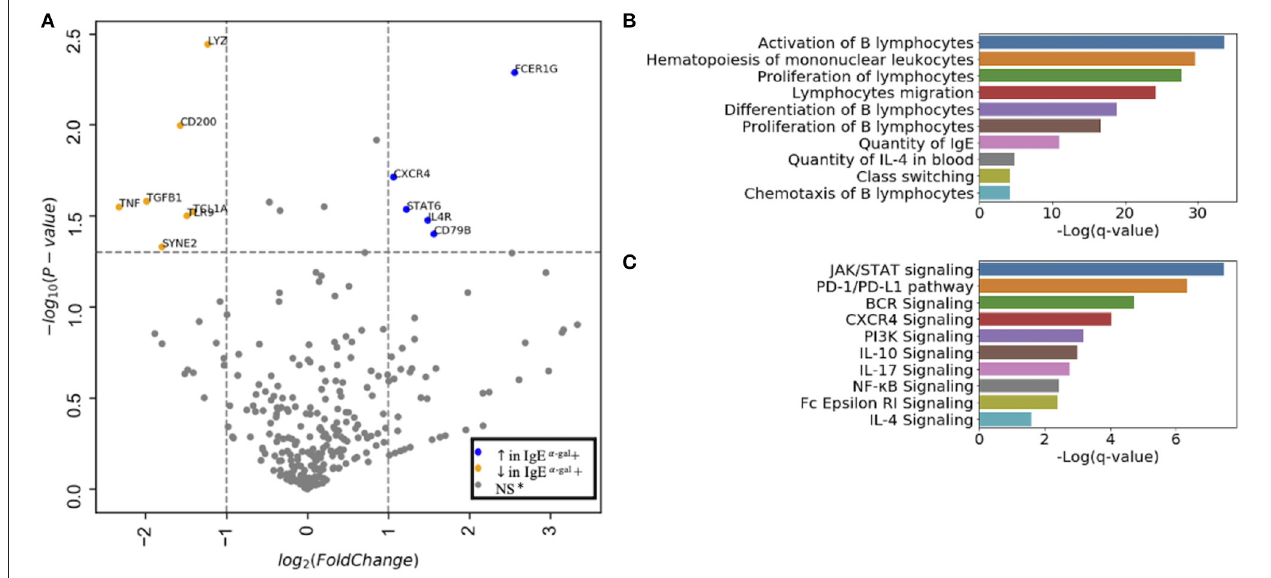
FIGURE 2 | CXCR4 signaling is enriched in CCR6 + SWM B cells of α -gal sensitized subjects. (A) Volcano plot of 488 gene array demonstrating DEGs of cluster 7 upregulated (blue) and downregulated (orange) in IgE α -gal + subjects. ( B,C) Significant cellular processes (B) and canonical pathways (C) enriched in IgE α -gal + in cluster 7 cells. ns,